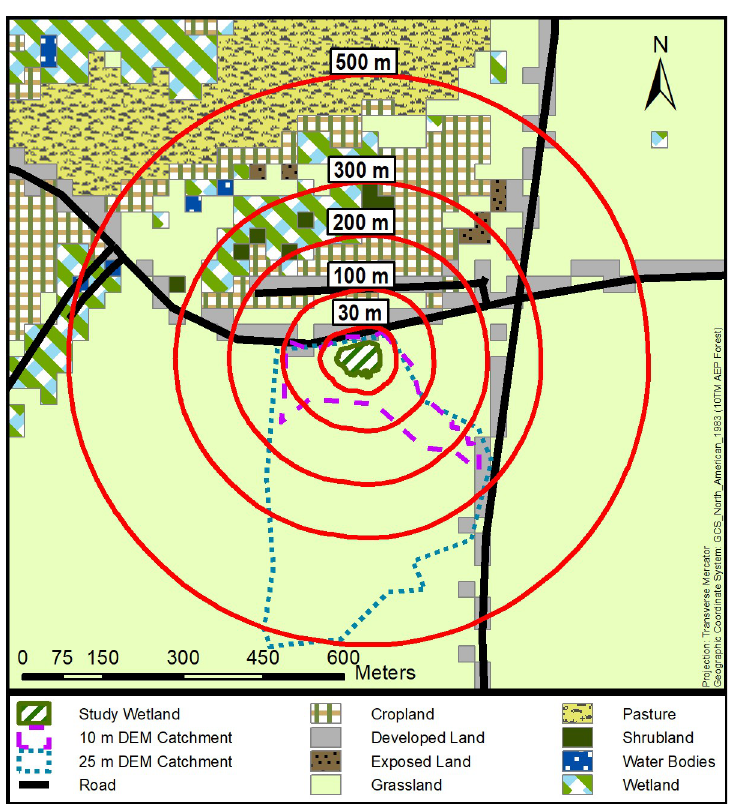
Fig 1. Different spatial extents used to characterize land-cover composition around study wetlands. Depicted is a 0.37 ha wetland situated in the Grassland natural region of Alberta, with land cover from 2014 (30 m pixels).